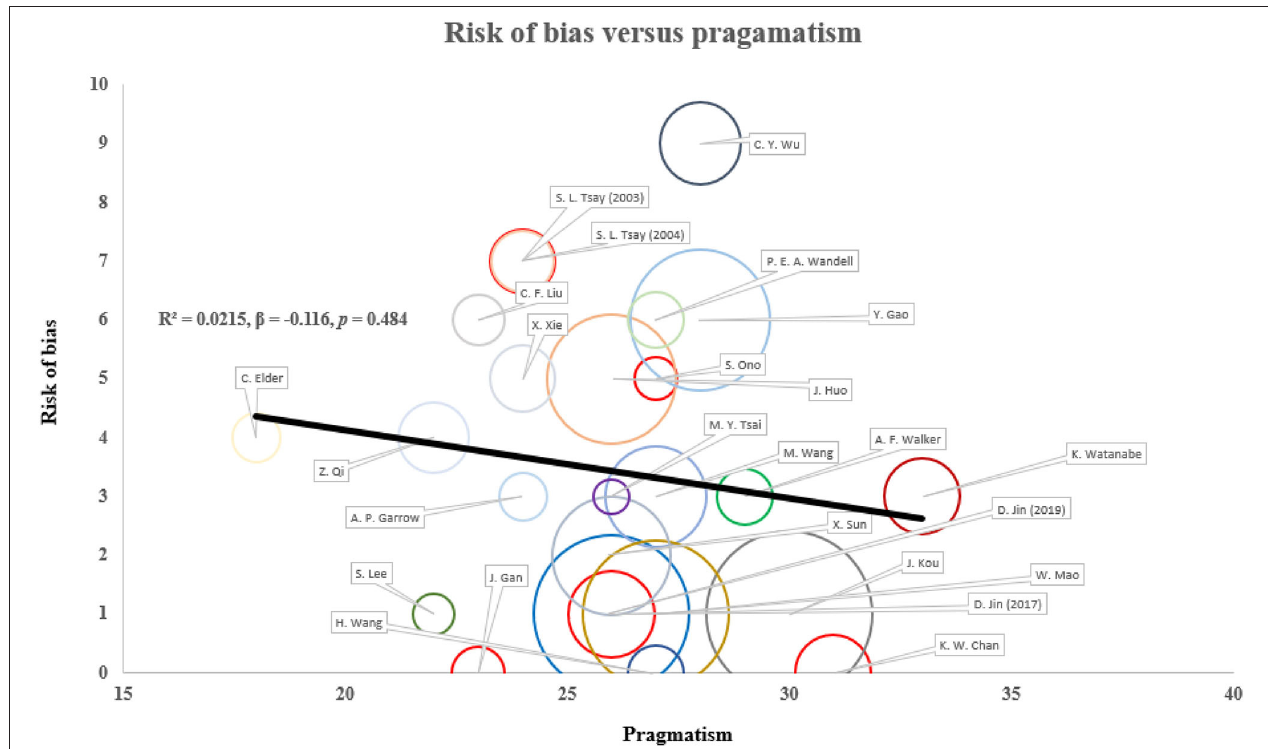
FIGURE 4 | Correlation between risk of bias and pragmatism in existing study designs. The risk of bias and pragmatism was assessed according to the Cochrane risk-of-bias tool and PRECIS-2 tool. Higher score corresponds to higher risk of bias and more pragmatism. Sample size is presented as the size of circle. There is no statistically significant correlation between risk of bias and pragmatism in both unadjusted and adjusted (publication year and sample size) models. Result is robust in sensitivity analyses replacing undetermined domains with extreme